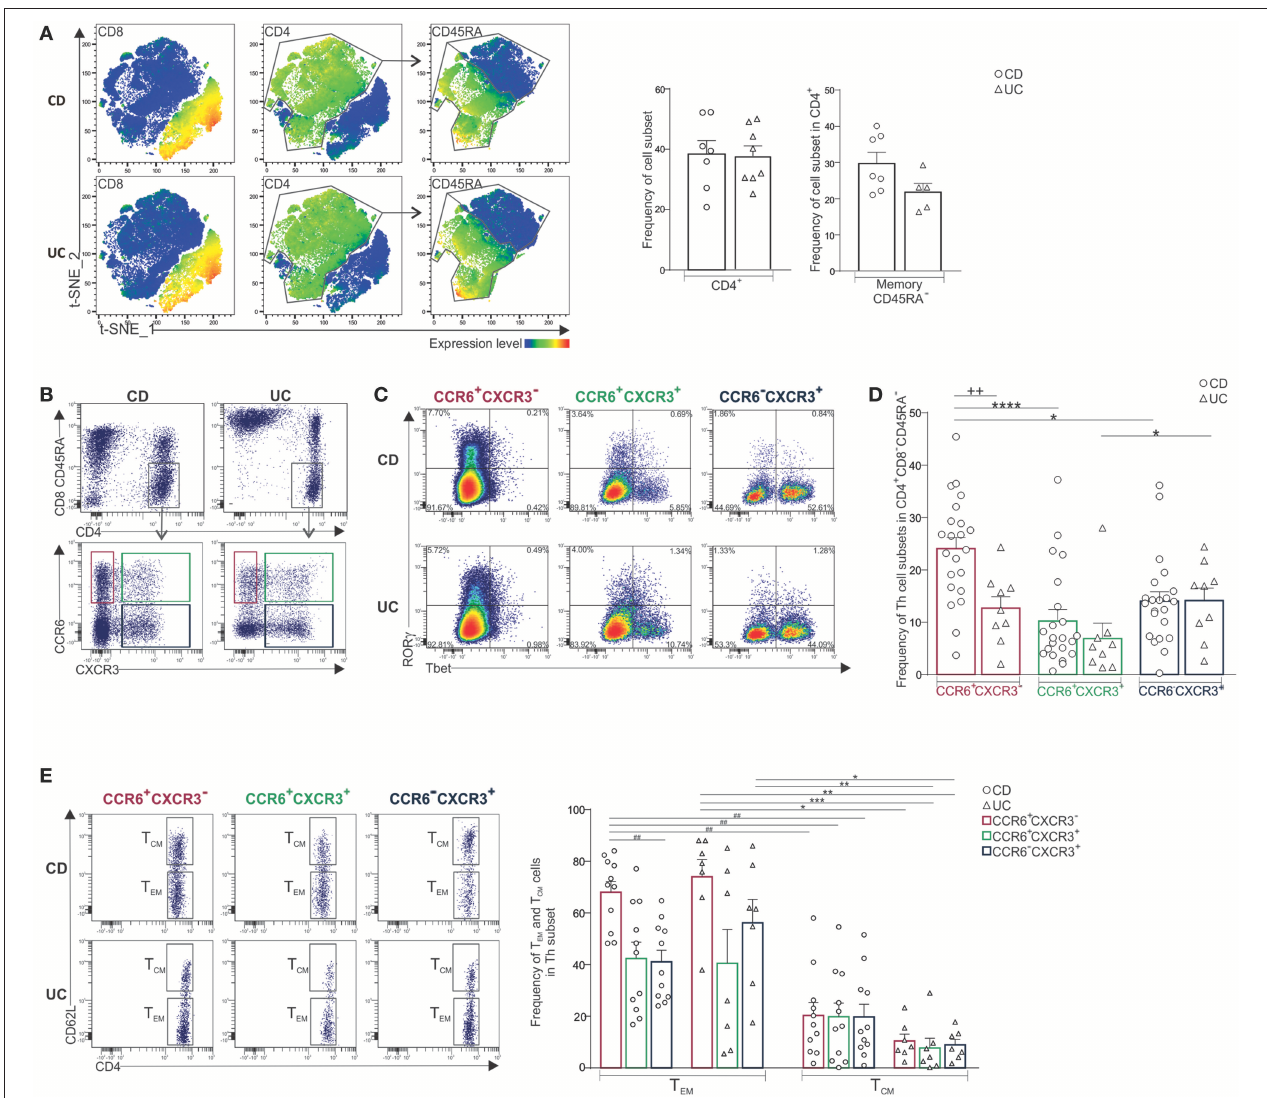
FIGURE 1 | Predominance of CCR6 + CXCR3-CD4 + T cells in mLNs of CD when compared to UC patients. (A) CD3 + T cells isolated from mLNs of CD and UC patients were concatenated for t-SNE analysis. Feature plots of the indicated antigens (left panels). Frequencies of CD4 + and memory CD45RA − T cells (right panels). (B) Representative dot plots of CCR6 + CXCR3 − , CCR6 + CXCR3 + and CCR6 − CXCR3 + CD4 + subsets, (C) their expression of ROR γ and Tbet, and (D) frequencies of indicated Th subsets. (E) Representative dot plots and frequencies of T EM (CD62L low ) and T CM (CD62L high ) among Th subsets. Unpaired t -test ( + ), Friedmann test followed by Dunn’s test (*) and repeated measures one-way ANOVA followed by Tukey’s test (#). * P < 0.05, ** ++ ## P < 0.01, and *** P < 0.001, **** P <